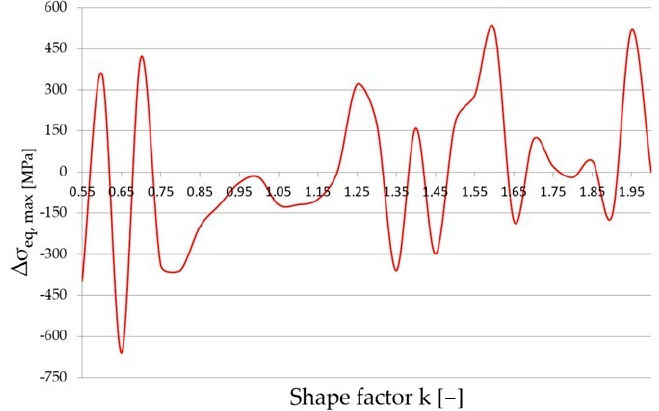
Figure 4. The influence of shape factor k on increment of equivalent stress.